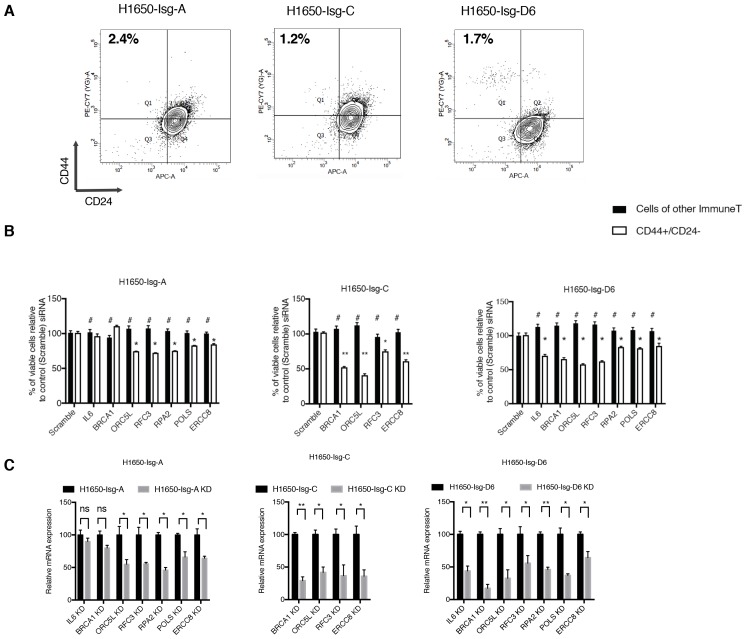
Validation of shRNA screen hits in H1650-derived isogenic clones, FACS sorted on the basis of surface expression of CD44 and CD24.(A) FACS profile of H1650-derived isogenic cell lines stained with CD44 and CD24 antibodies. The numbers in bold represent the percentage of cells that are CD44+/CD24−. (B) The charts represent the percentage of viable CD44+/ CD24− cells and cells of other immune types upon transfection with the indicated siRNA oligonucleotides relative to control (scramble siRNA). Each bar represents mean ± SD of three technical replicates from two independent experiments. 10,000 cells were analyzed by FACS for each replicate of each sample. (C) Efficiency of knockdown upon transfection with the indicated siRNA oligonucleotides and compared to scramble siRNA transfected control cells. Cells were collected 3 days post transfection and analyzed for expression of the indicated mRNA. Each bar represents mean ± SD of three replicates. p-value *<0.05, **<0.005, ***<0.0005, unpaired t-test. Non-significant differences are shown by the symbol ‘#’ or ‘ns’.